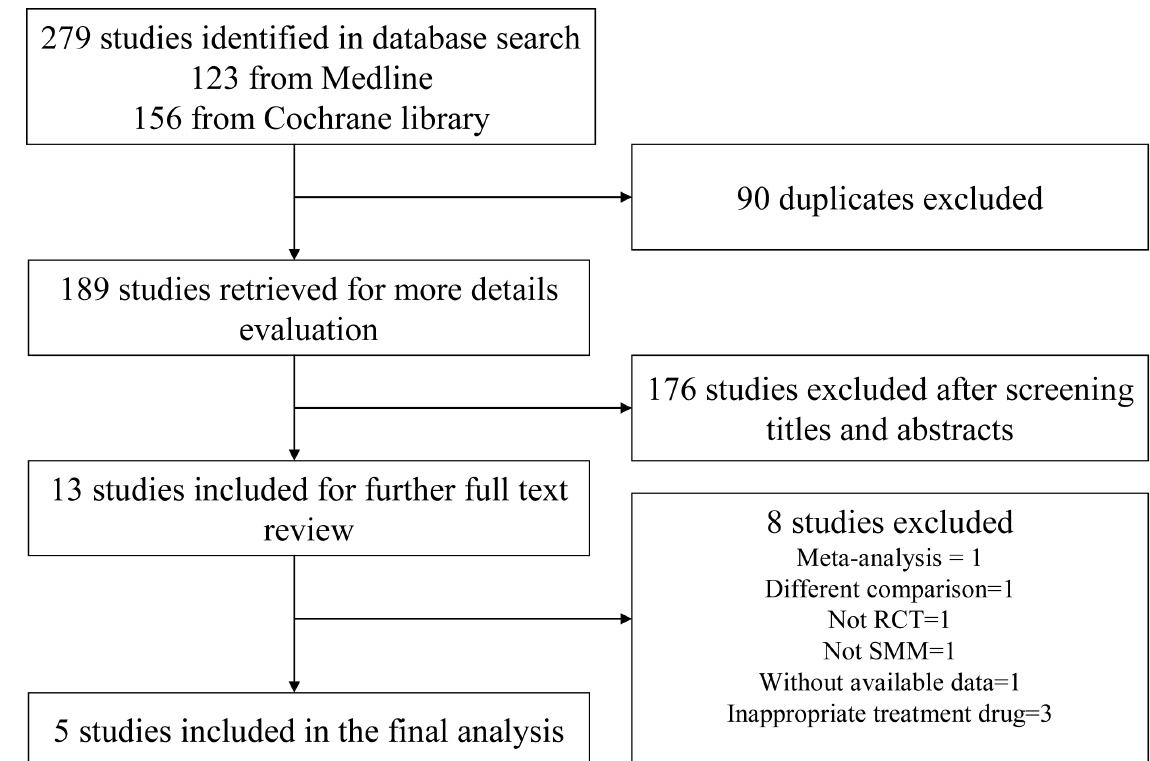
Figure 1. Flowchart of the selection of studies. doi:10.1371/journal.pone.0109758.g001 Table 1. Characteristics of studies fulfilling inclusion criteria in the